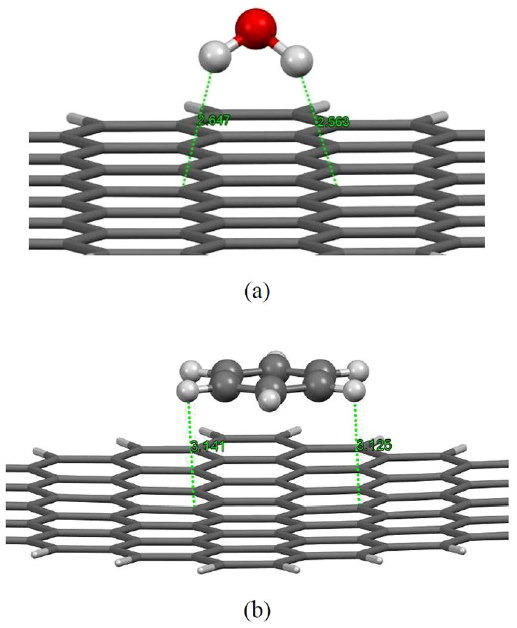
Figure 5. Optimized structures with DFT - revPBE-D3/SVP method for ( a ) H 2 O and ( b ) benzene molecules adsorbed onto graphene flake (All distances are in